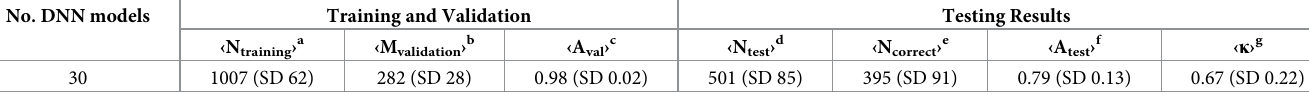
Table 5. Classification of Abs recognizing two epitopes at either the base (ADI-15734) or the HR2/MPER region (ADI-15974) of the EBOV-GP trimer. We colored the fingerprints for the DNN models according to the charge coloring code. No. DNN models Training and Validation Testing